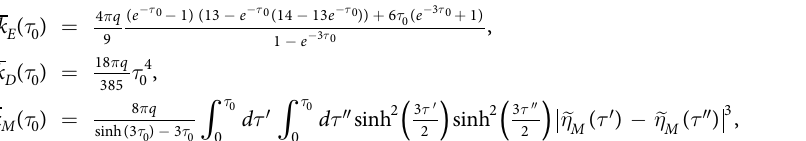
where rescaled conformal time η αη ≡   is used for convenience. These expressions do not depend on spatial cut- , so that boundary effects, i.e., the off ρ 0 because they are approximations for spatially large regions with ρ τ  0 0 contributions to the average degree from nodes with ρ s close to ρ 0 , are negligible. It is evident from the exposition above including (8, 10) that the only three out of the original five parameters defining the RGG ensemble with N nodes and average degree k —sprinkling density δ ≡ N V / , temporal scale λ , spatial scale α , and temporal and spatial cutoffs t 0 and r 0 —are independent because N depends only three dimen- sionless parameters, q , ρ 0 , and τ 0 , while k depends only on two, q and τ 0 . This is because sprinkling density δ sets the discreteness scale, which can be rescaled by λ : two graph ensembles with different δ s and λ s are the same if their rescaled sprinkling density q = δλ 4 is the same. Similarly, two graph ensembles with different λ s and t 0 s are the same if their τ 0 s are the same, and two graph ensembles, and even spacetime regions, with different α s and r 0 s are the same if their ρ 0 s are the same. Therefore, parameters q , ρ 0 , τ 0 form one natural choice of independent parameters, the one we use in simulations below. Yet any three independent functions of these parameters is an equivalent choice. In particular, N and k are two such independent functions, so that N , k , τ 0 is another choice of parameters that we also use in simulations. Yet we note that one parameter in these two sets of three parameters